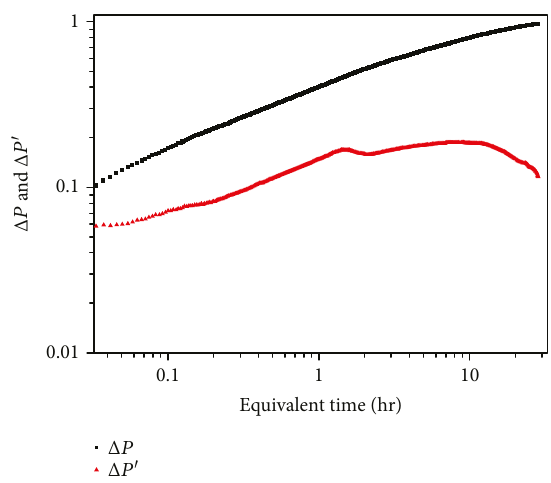
Figure 26: The log-log plot of well A last BU. At late time, the pressure derivative goes